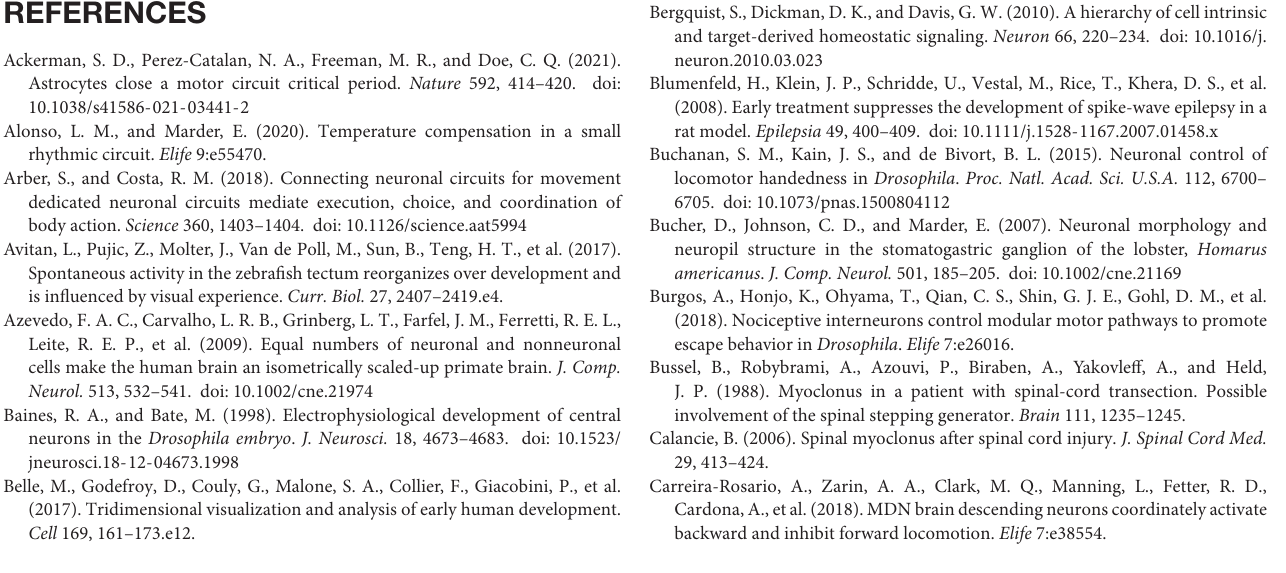
Supplementary Animation 1 | Activity in the Drosophila Larva A27 h-related Locomotor Circuit. Animation is a copy of Figure 2 , with depolarised neurons highlighted in green, and hyperpolarised neurons highlighted in red. Activity is depicted as it is described in the text, and is shown progressing from posterior ( n + 1 ) to more anterior segments ( n , n - 1 ) of the body and ventral nerve cord. The progress of this activity has been slowed down (4 s per segment in animation, versus ∼ 1 s per stride in real time) to improve